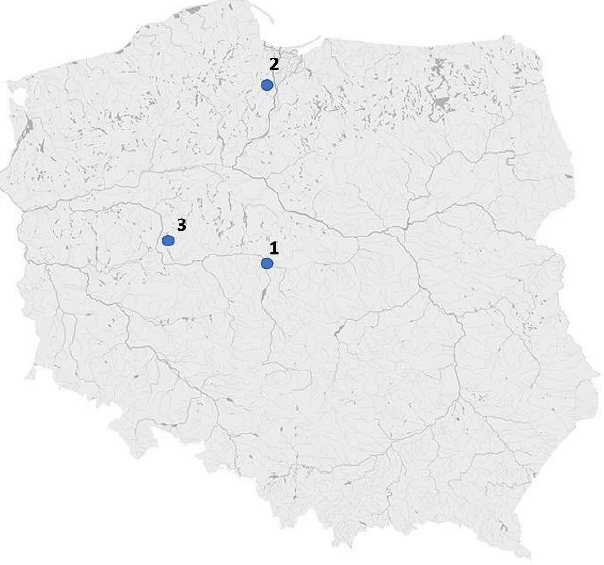
Figure 4. The sites of plant collection in Poland (1 — Konin , 2 — Tczew , 3 —Poznań ).